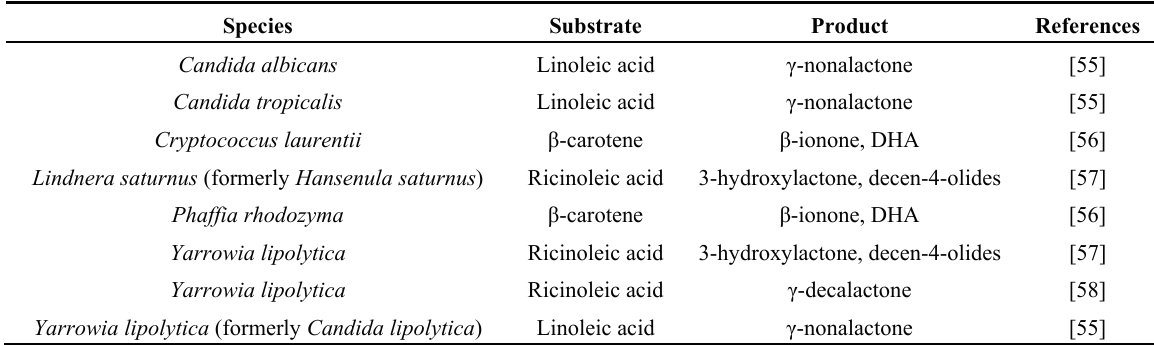
Table 2. Studies carried out in the last fifteen years on the use of NCYs for producing lactones via